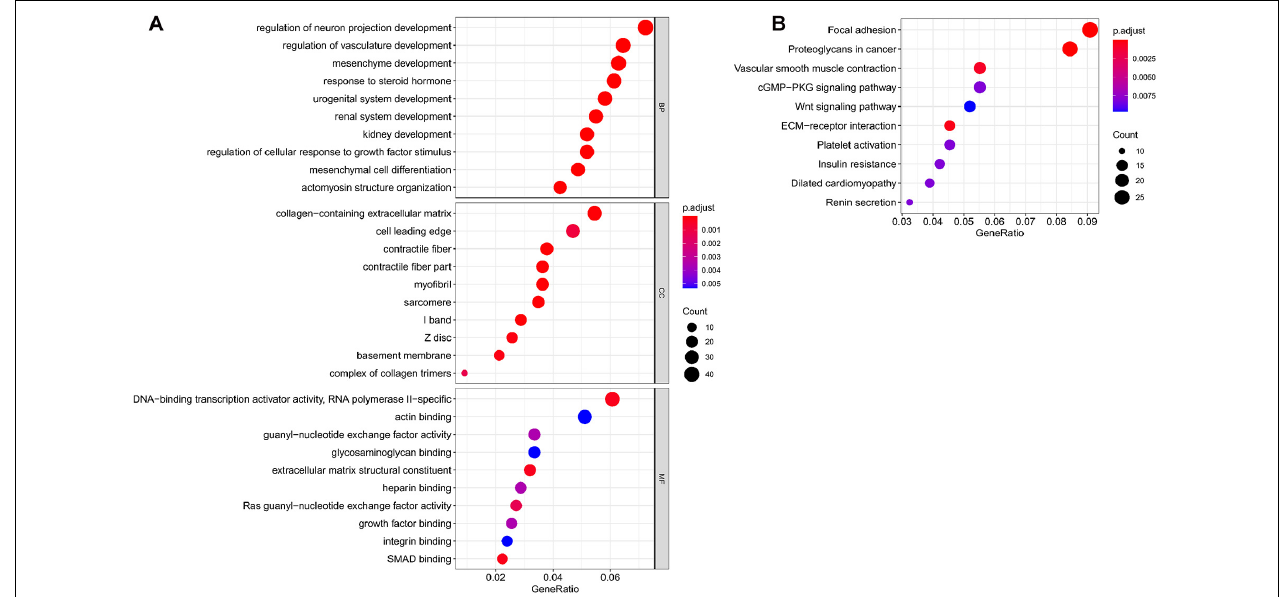
FIGURE 4 | Functional enrichment analysis of targeted mRNAs from the hub miRNAs. (A) Dotplot of the top ten results from the GO analysis in terms of BP, CC and MF with the adjusted p -value from smallest to largest, respectively, and (B) dotplot of the top ten KEGG enrichment pathways. GO, Gene Ontology; BP, biological process; CC, cellular component; MF, molecular function; KEGG, Kyoto Encyclopedia of Genes and Genomes; miRNA, microRNA; mRNA, messenger RNA.